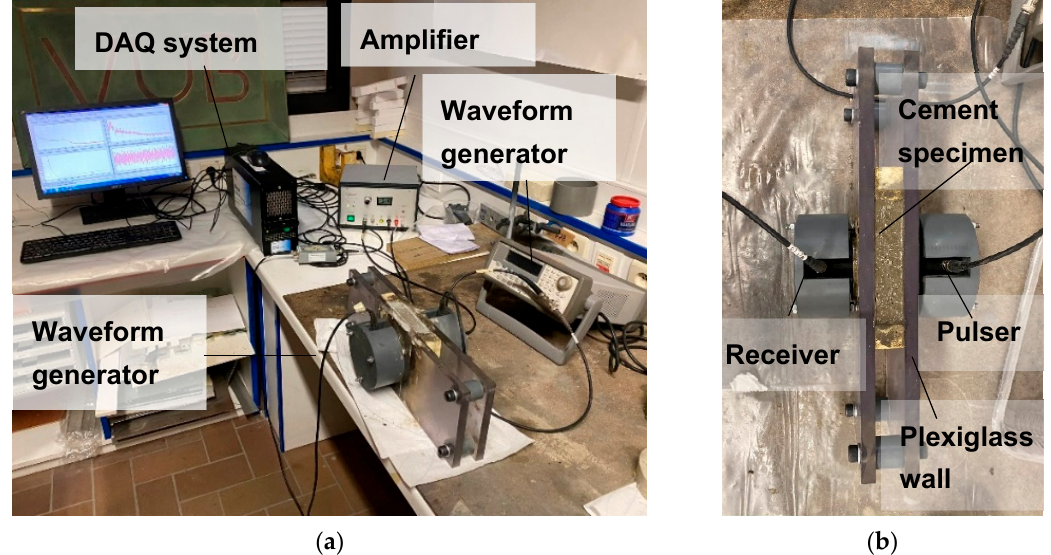
Figure 1. ( a ) Photograph of the experimental setup and ( b ) close up of the cement specimen and sensors